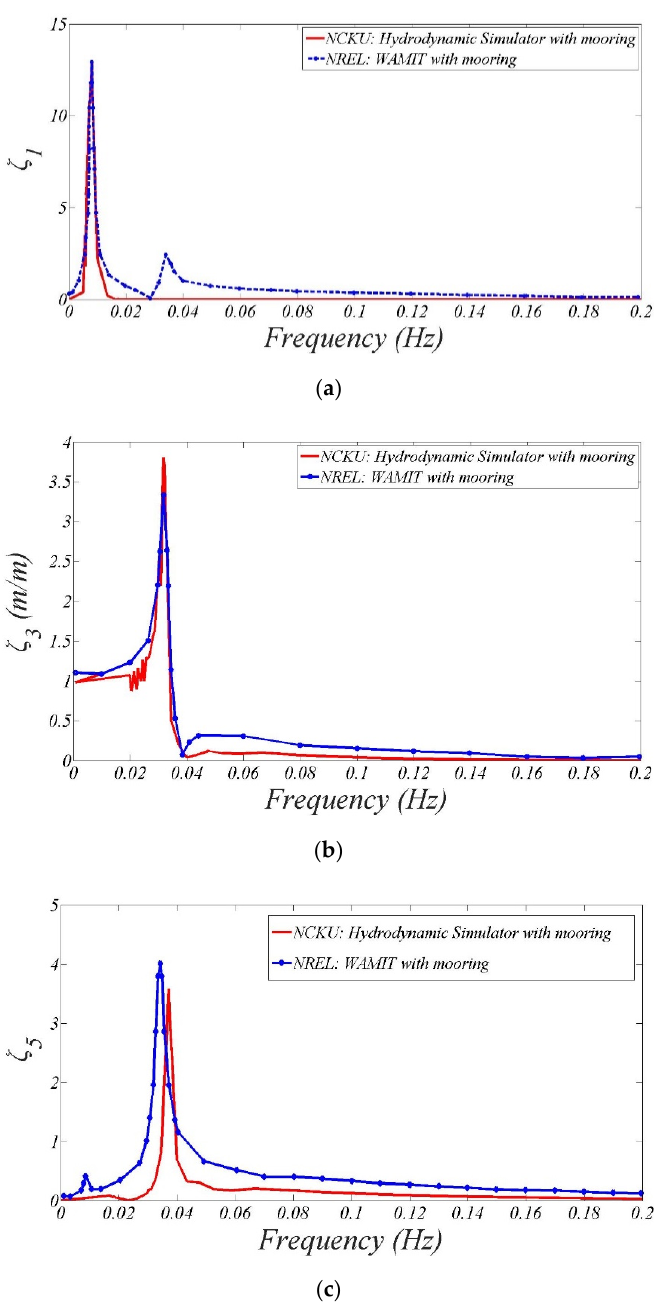
Figure 15. The performance of ( a ) surge, ( b ) heave, and ( c ) pitch RAOs as a function of wave frequency for the OC3-Hywind spar by comparing hydrodynamic simulator with WAMIT. Figure 16a–c exhibit time variations of wave exciting force ( F ext ) / moment ( M ext ), radiation damping force ( F Rd ) / moment ( M Rd ), radiation added-mass force ( F Ra ) / moment ( M Ra ), buoyancy force ( F B ) / moment ( M B ) and mooring force ( F M ) / moment ( M M ) at the natural frequencies of the surge,